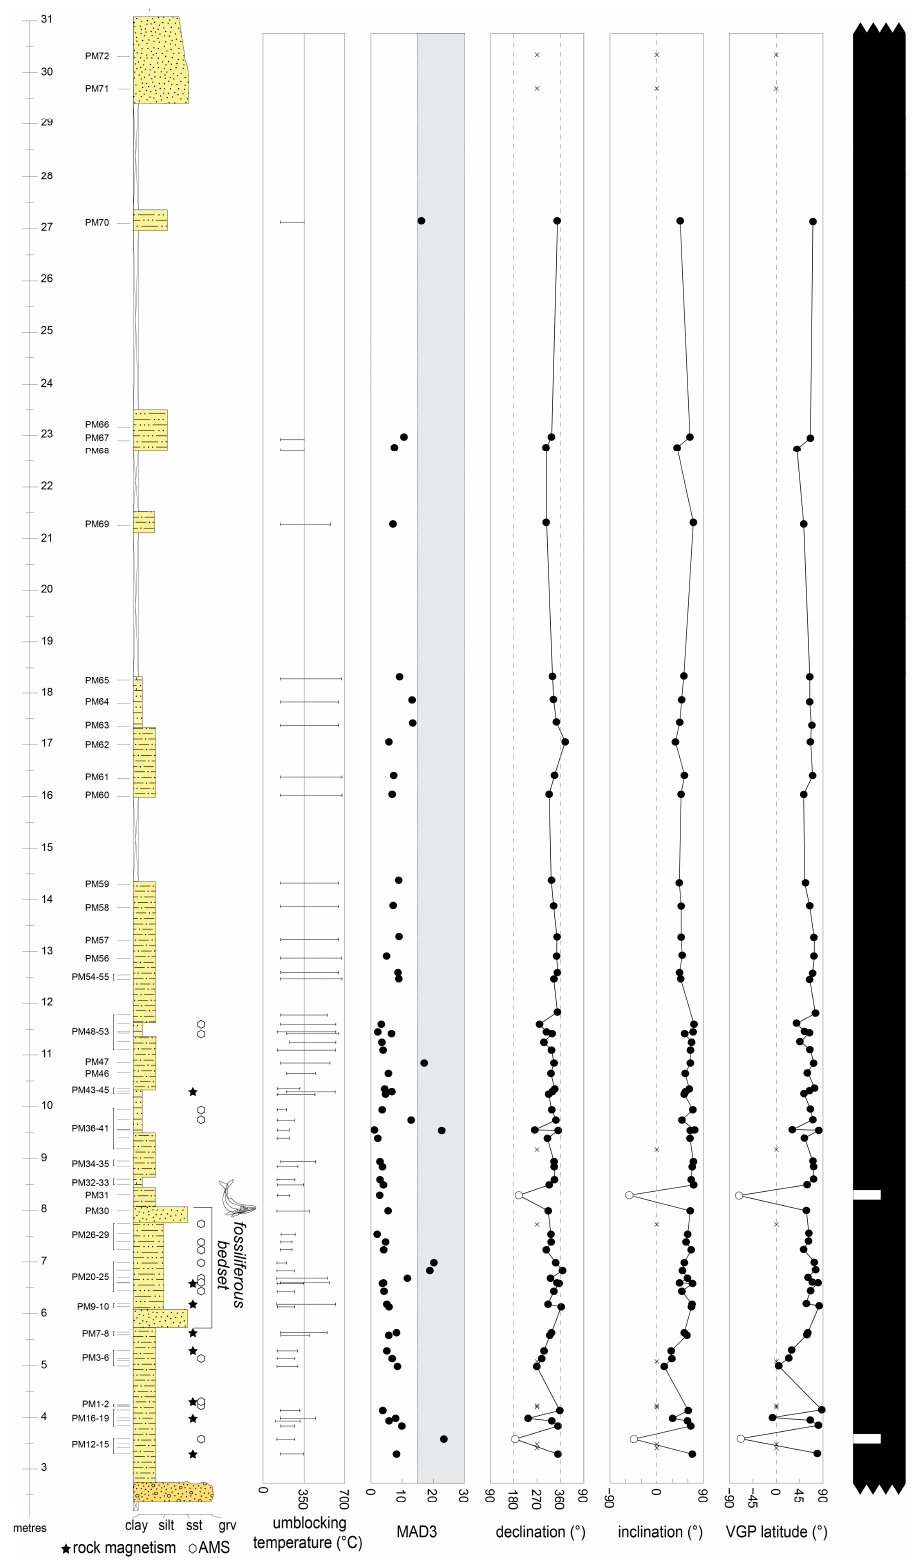
Figure 7. Stratigraphic log of section H (see Figure 3b,c for location and stratigraphic position, respectively) with (from left to right, unblocking temperature of ChRM, mean angular deviation (MAD), declination, inclination and virtual geomagnetic pole (VGP) and interpreted magnetic